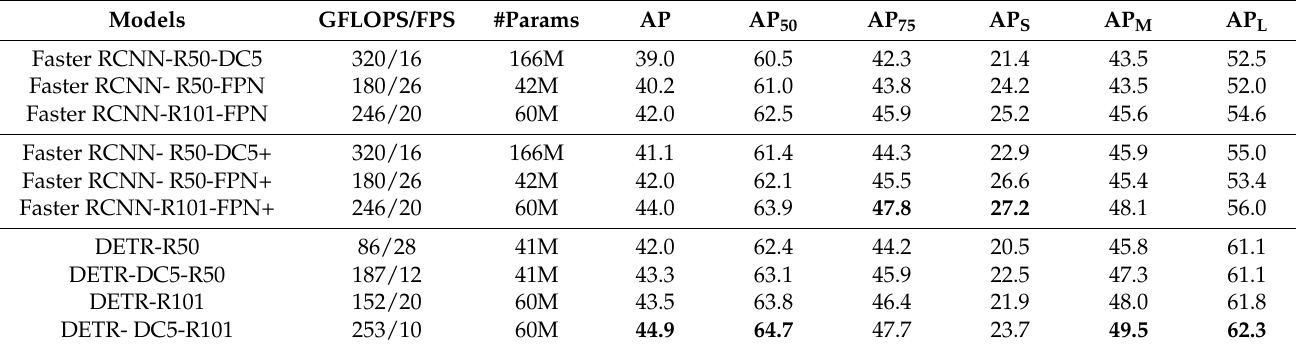
Table 3. The performance comparison of DETR with Faster R-CNN with ResNet-50 and ResNet-101 backbones on the COCO 2017 validation set. The results of Faster R-CNN models in Detectron2 [78] and GIoU [79] are shown in the top three rows and middle three rows, respectively. DETR models achieve comparable results to heavily tuned Faster R-CNN baselines, having lower AP S but greatly improved AP L . S: small objects, M: medium objects, L: large